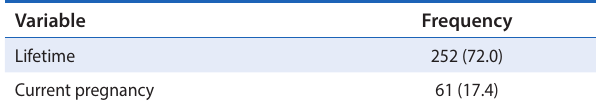
Table 2: Respondents’ experience of IPV ( n = 350)